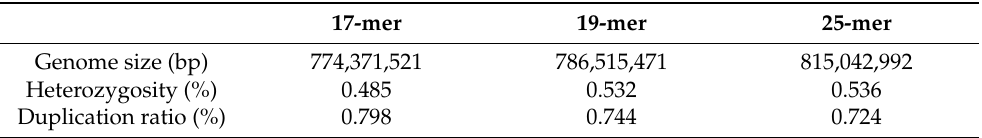
Table 2. Statistics of the estimated genome size by GenomeScope.